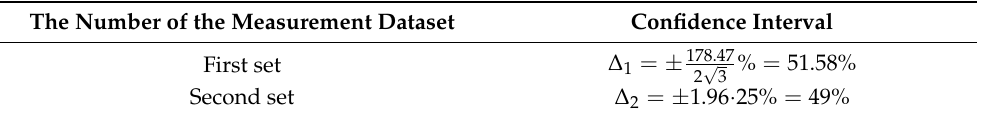
Table 5. Confidence intervals for measurement results of both sets of